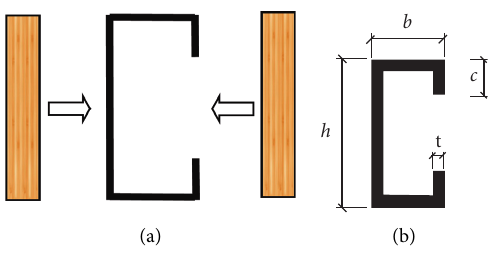
Figure 3: Bamboo steel composite skeleton. (a) Structure of the skeleton. (b) Dimension of C-type